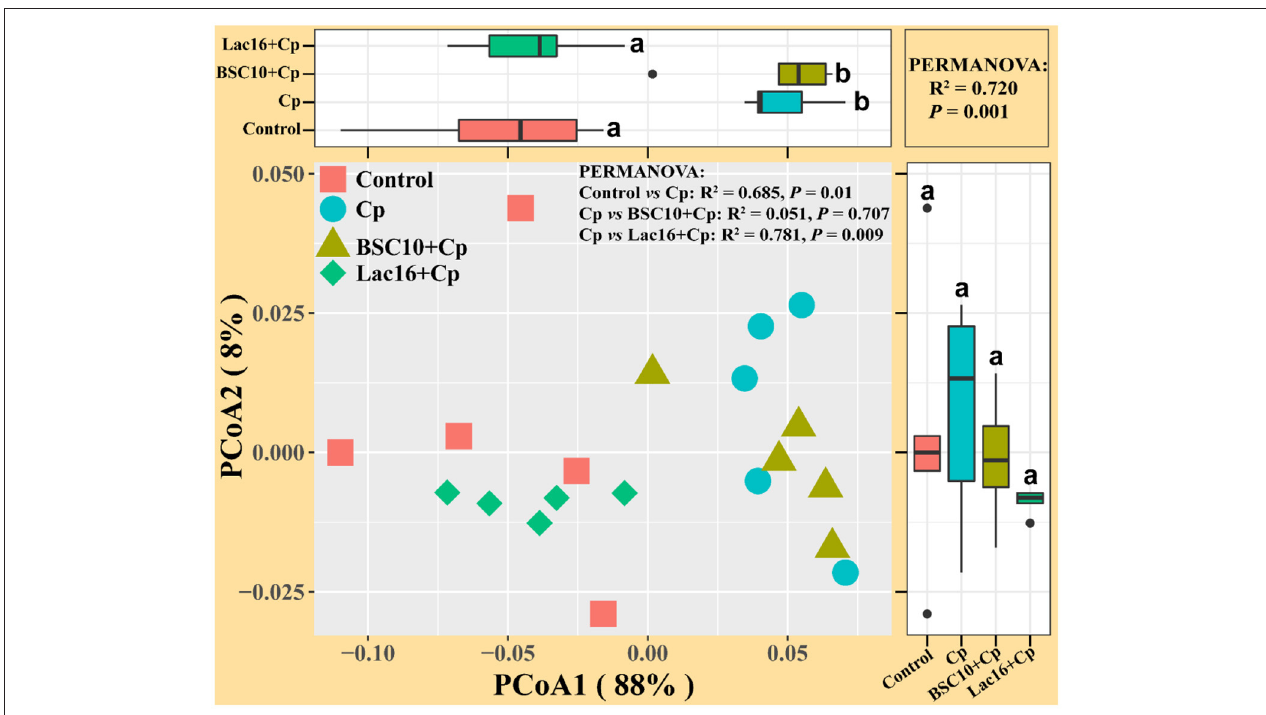
FIGURE 6 | Principal coordinates analysis ( PCoA ) of predicated metabolic functions among groups based on Bray-Curtis distance. a,b indicate a significant difference ( p < 0.05).